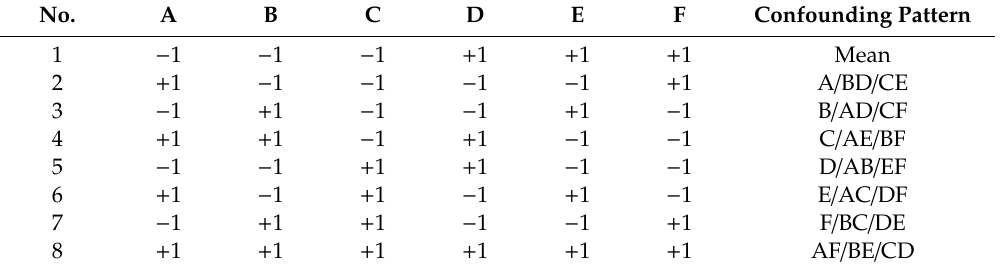
Table 3. Array of